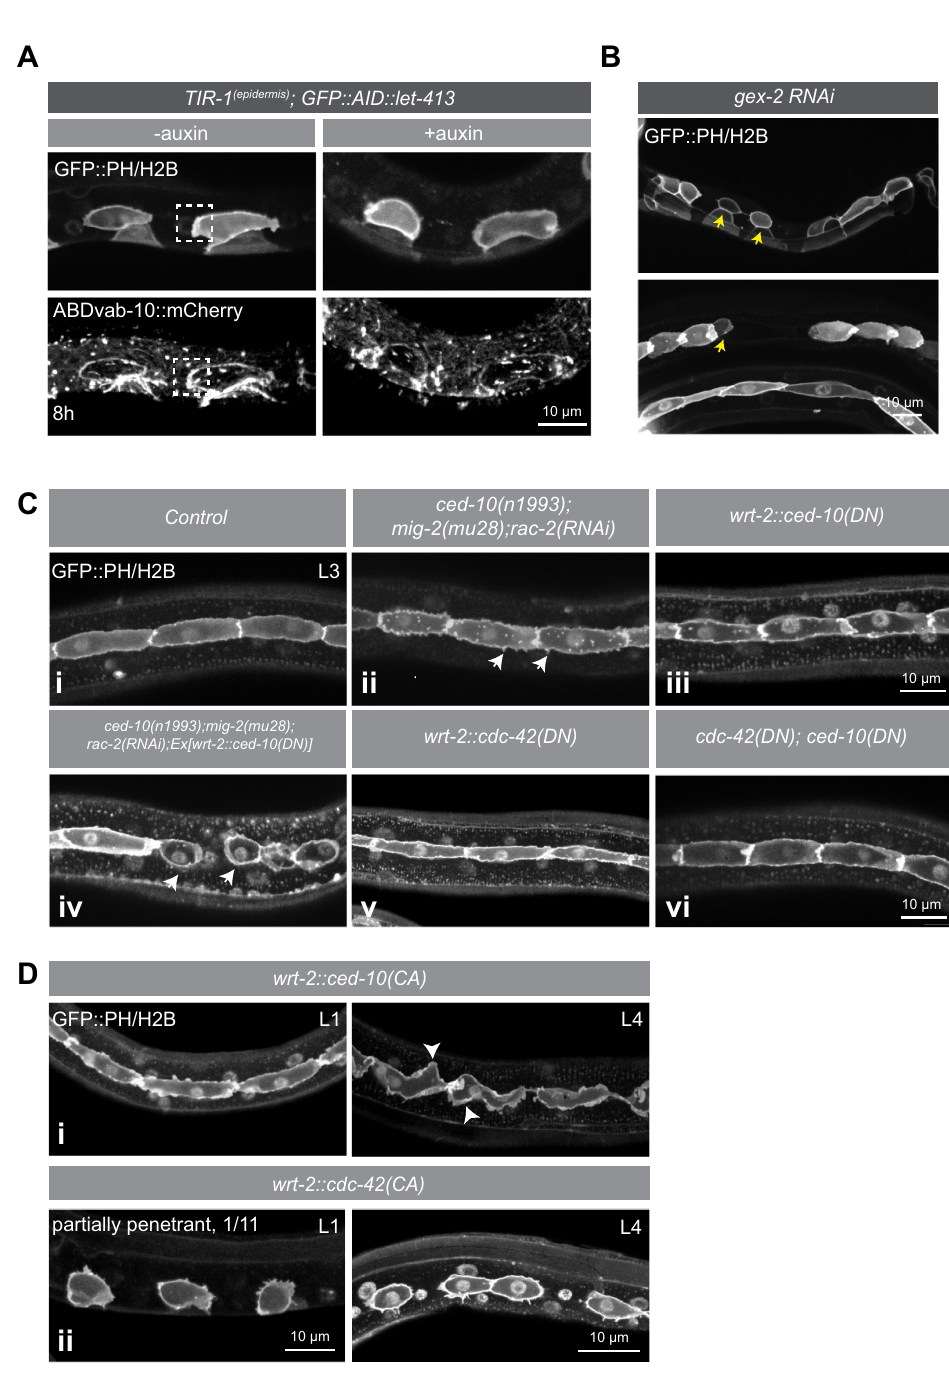
Fig 4. Involvement of Rac and Cdc42 GTPases in seam cell extension ( A ) Distribution of the PH::GFP and H2B:: GFP markers and the VAB-10[ABD]::mCherry actin probe in the epidermis of Pwrt-2 :: TIR1 :: BFP; GFP :: AID :: let-413 animals without (-auxin) and in the presence of auxin (+auxin) at 8 h post hatching (strain BOX625). Images are single planes of the apical domain of the seam cells. White dotted boxes indicate the enrichment of VAB-10[ABD] in the seam cell protrusions. ( B ) Distribution of the GFP::PH and GFP::H2B marker in gex-2(RNAi) animals (strain SV1009). Yellow arrows point to defects in seam cell protrusions and seam cell shape. Defects were observed in 7/31 gex-2 (RNAi) escaper animals examined. Due to severity of phenotype, an exact larval stage cannot be determined. ( C ) Distribution of the GFP::PH and GFP::H2B markers in control animals, and in animals with indicated genetic backgrounds and methods of reducing the activity of Rac family members or CDC-42. i = control (strain SV1009), ii = triple Rac inactivation (strain BOX699), iii = CED-10(DN) (strain BOX697), iv = CED-10(DN) combined